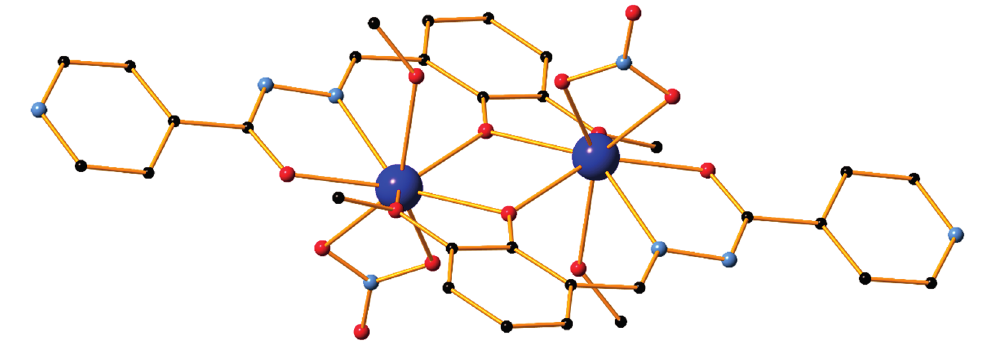
Figure 1. The structure of 1-Dy as reported by Murugesu et al . [44]. H atoms and solvent molecules are omitted for clarity. Colour code Dy (purple), C (black), N (blue), O